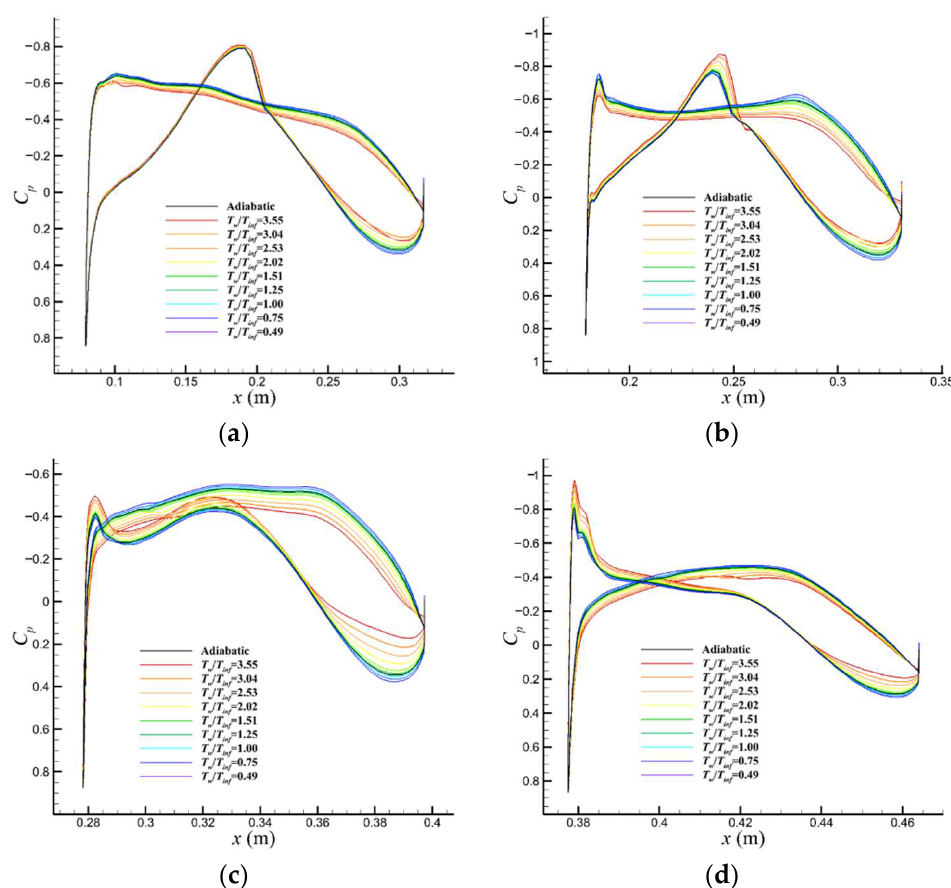
Figure 11. Effect of temperature gradient on pressure distributions on the wing. ( a ) Slice at 0.1b; ( b ) slice at 0.225b; (c) slice at 0.35b; ( d ) slice at 0.475b.